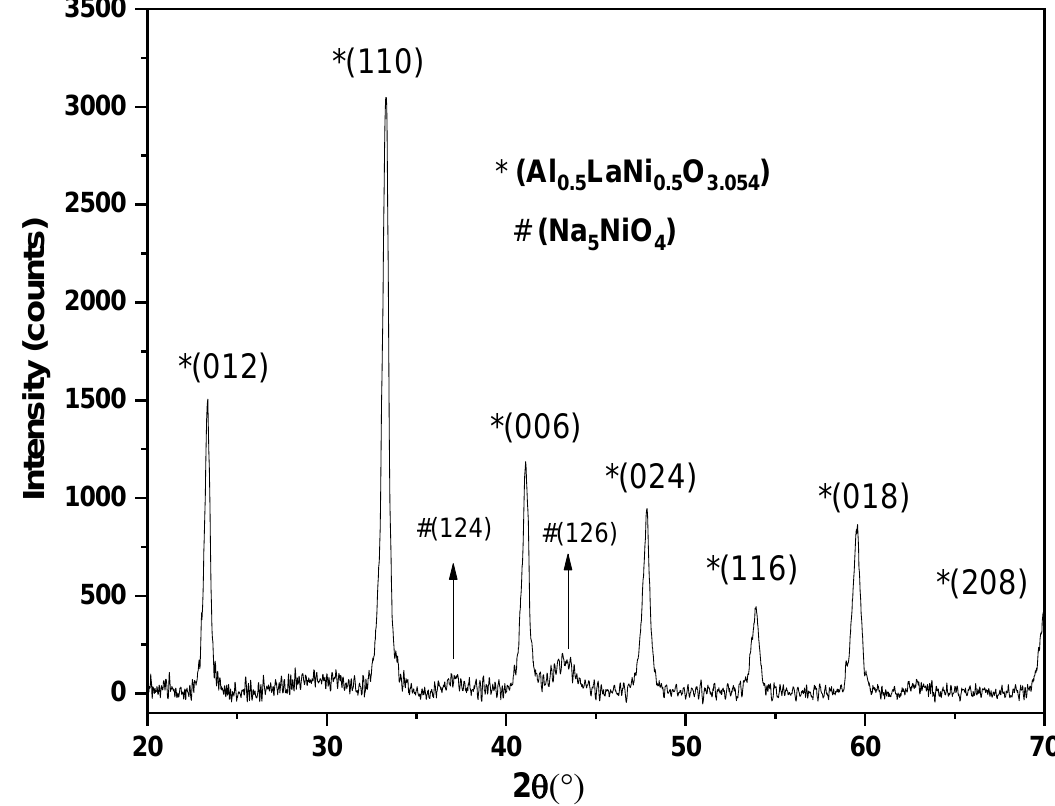
Figure 2. XRD profiles of catalyst calcined at 725 °C.